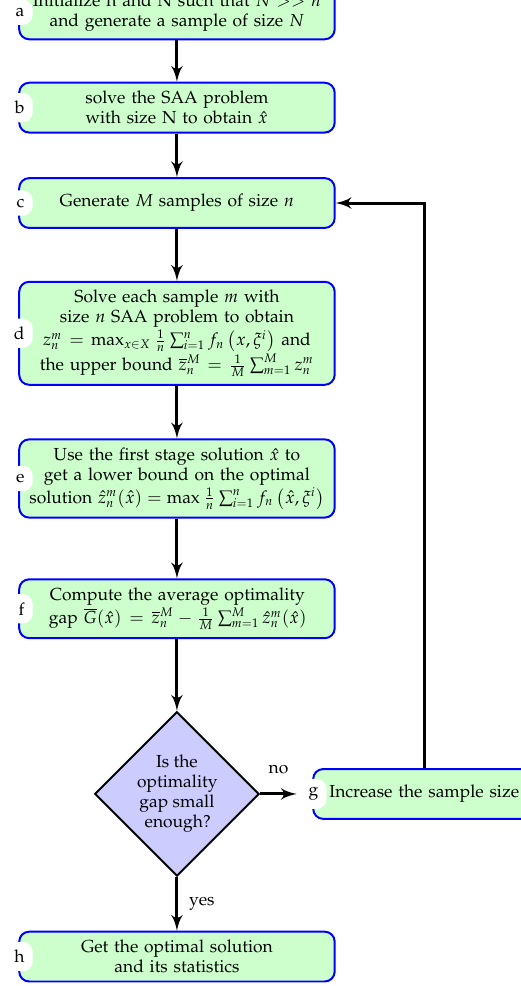
Figure 1. Flow chart of sample average approximation